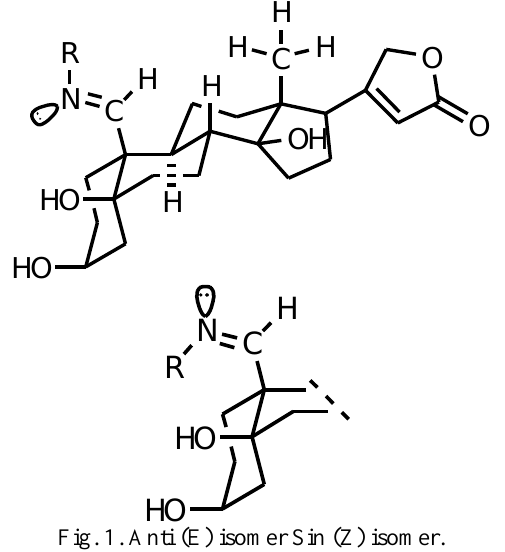
Fig. 1. Anti (E) isomer Sin (Z) isomer.